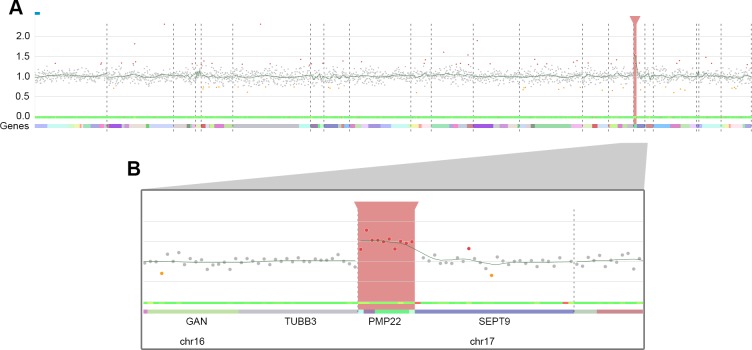
Visualization of CovCopCan.A. General view. Each dot corresponds to an amplicon. The amplicons are distributed on the x-axis according to their genomic position. The y-axis corresponds to the normalized values. Grey dots indicate a “normal” value, whereas red or orange dots indicate duplicated and deleted amplicons, respectively. The names of the gene and chromosome number are located at the bottom of the figure. The green curve shows the Loess regression. The thick green ribbon is a noise heatmap in which green indicates a stable amplicon in all samples (see S1 File). The red rectangle highlights a CNV region. B. Zoom on the duplicated region covered by 10 amplicons (PMP22).